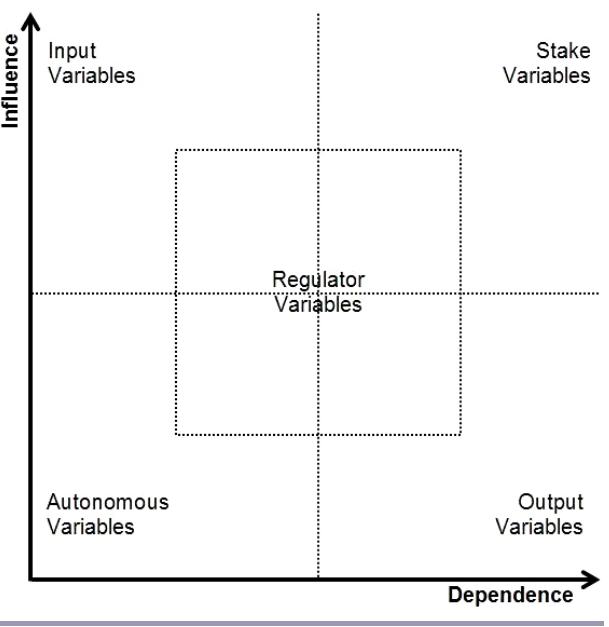
Fig. 4 . Clustering of variables according to their influence and dependence.